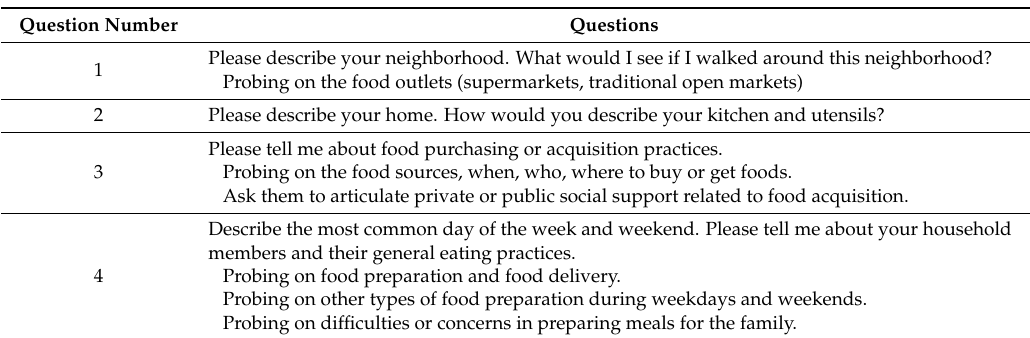
Table 1. Key questions in the in-depth interview guide for understanding food acquisition from private and public social networks in South